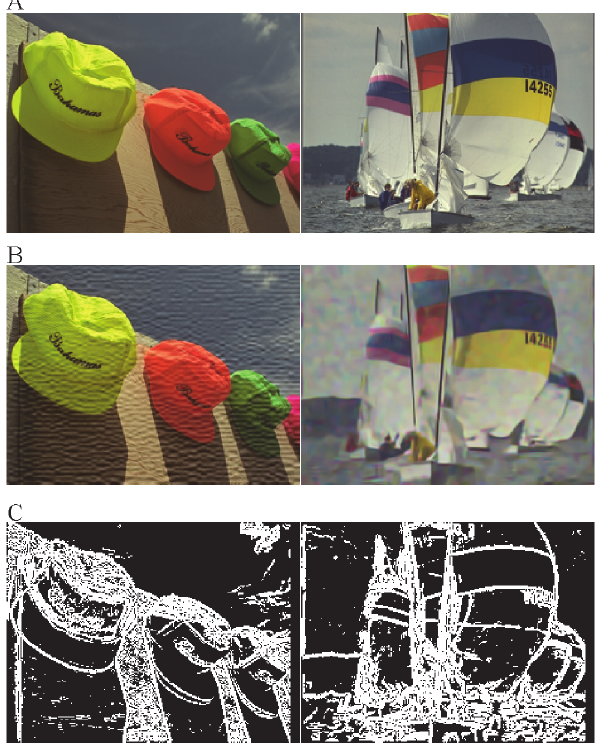
Fig 4. Examples of the image partition, i.e., patch classification. (A) Reference images. (B) Distorted images. (C) Results of our partition. In Fig. 4C, the “ white ” part is the “ Type I ” region, and the “ black ” part is the “ Type II ”